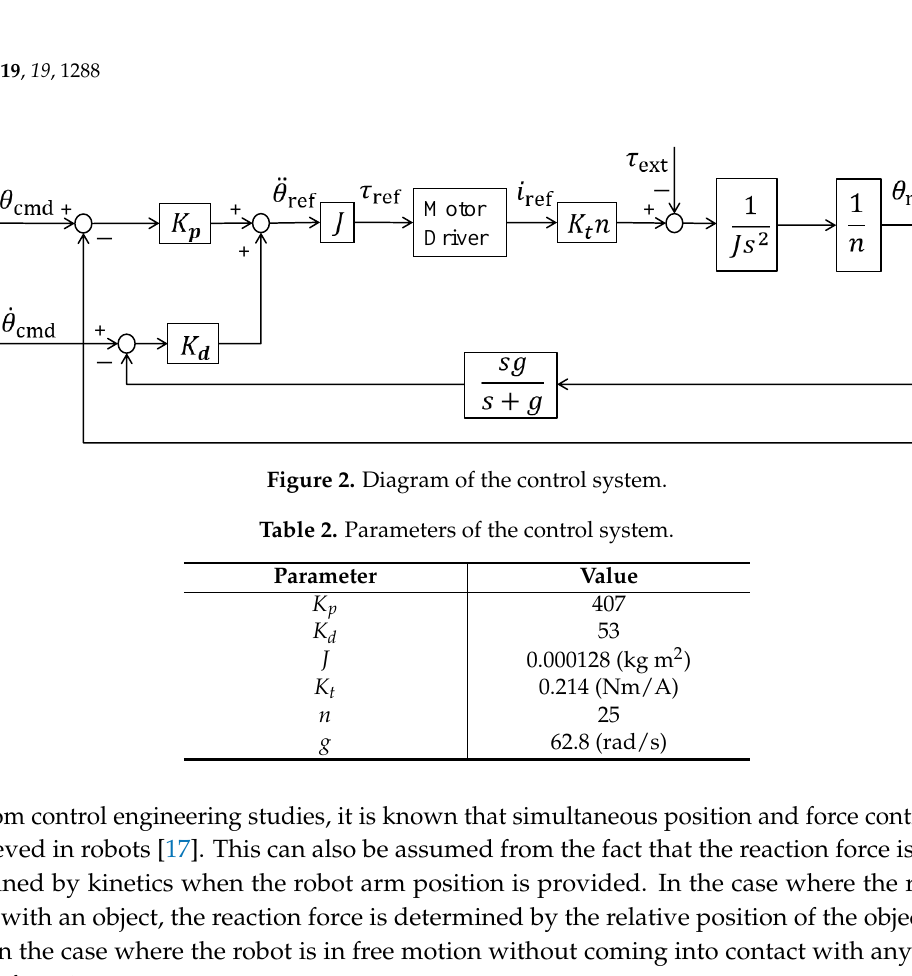
Figure 2 . Training scene layout.